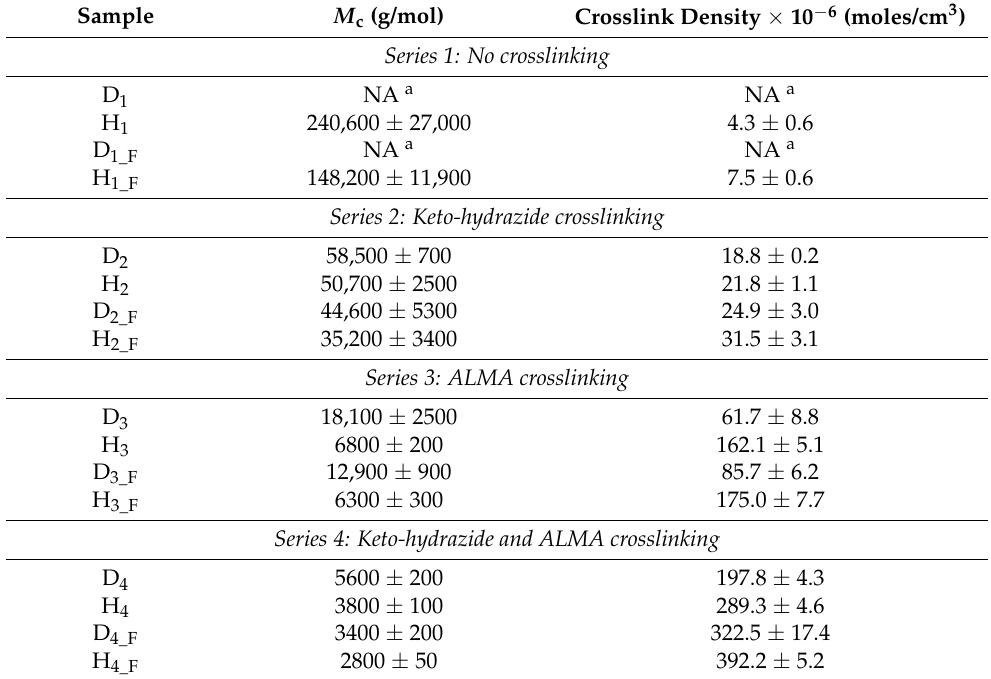
Table 5. Degree of crosslinking introduced into latex copolymers differing in the fluorination of the second-step polymer, emulsifier type, and covalent crosslinking strategy in terms of the average molar mass between crosslink junctions ( M c ), and crosslink